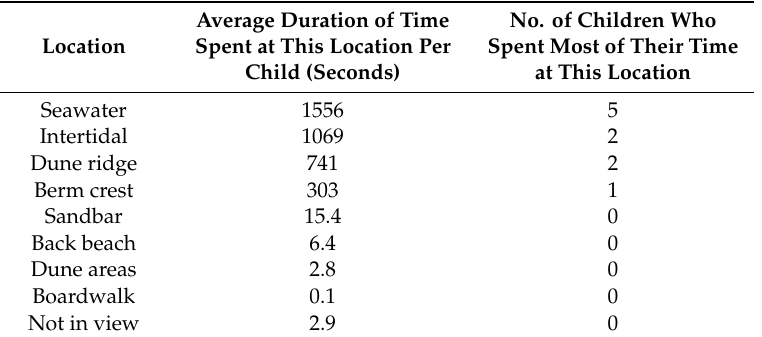
Table 1. Duration of time and number of children at specified locations. Statistics correspond to the 10 children who acquired new abrasions.